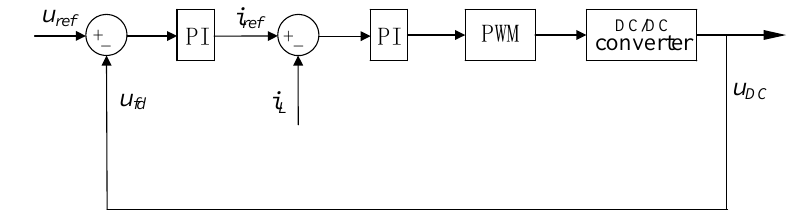
Figure 8. Controls of the interface circuit of super capacitor.